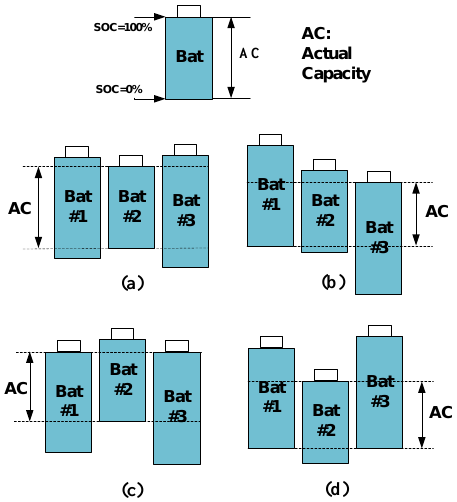
Figure 1. Batteries’ relative SOC in one pack: ( a ) Battery 2 is the first one to be fully charged and discharged; ( b ) Battery 3 is the first one to be fully charged, Battery 1 is the first one to be fully discharged; ( c ) Battery 1,3 are the first ones to be fully charged, Battery 2 is the first one to be fully discharged; ( d ) Battery 2 is the first one to be fully charged, Battery 1,3 are the first ones to be fully